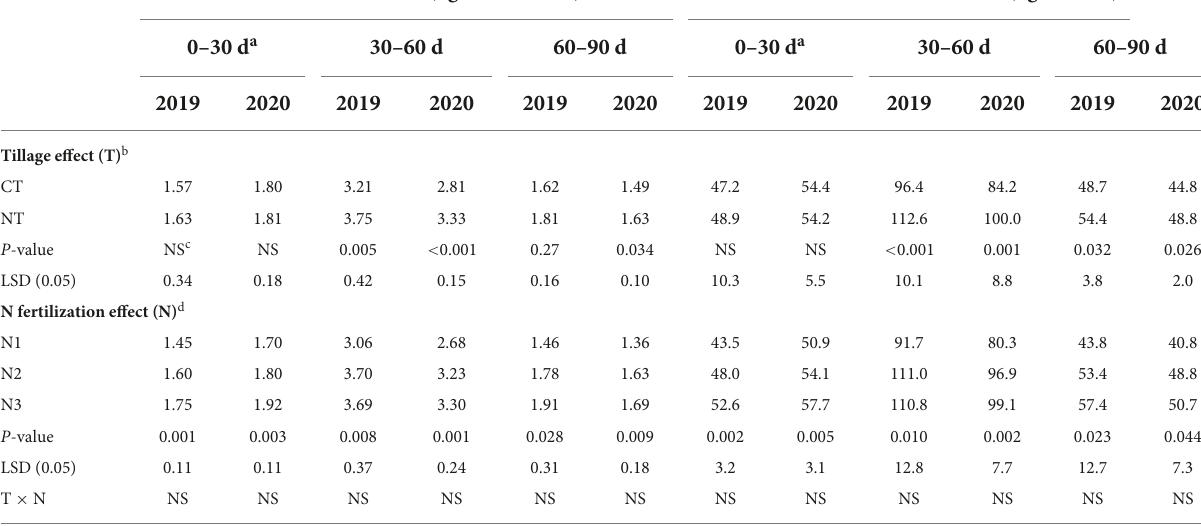
TABLE 3 The N accumulation rate (NacR) and amount (NacA) of spring wheat during 0—0, 30–60, and 60–90 day after emergence as affected by tillage and N fertilization treatments in 2019 and